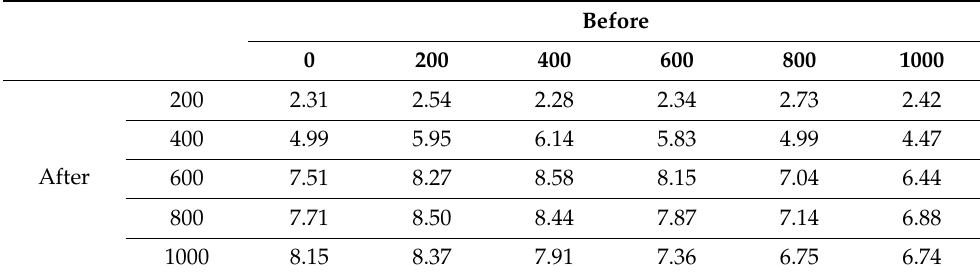
Table 12. The perceived naturalness of the female model (android).